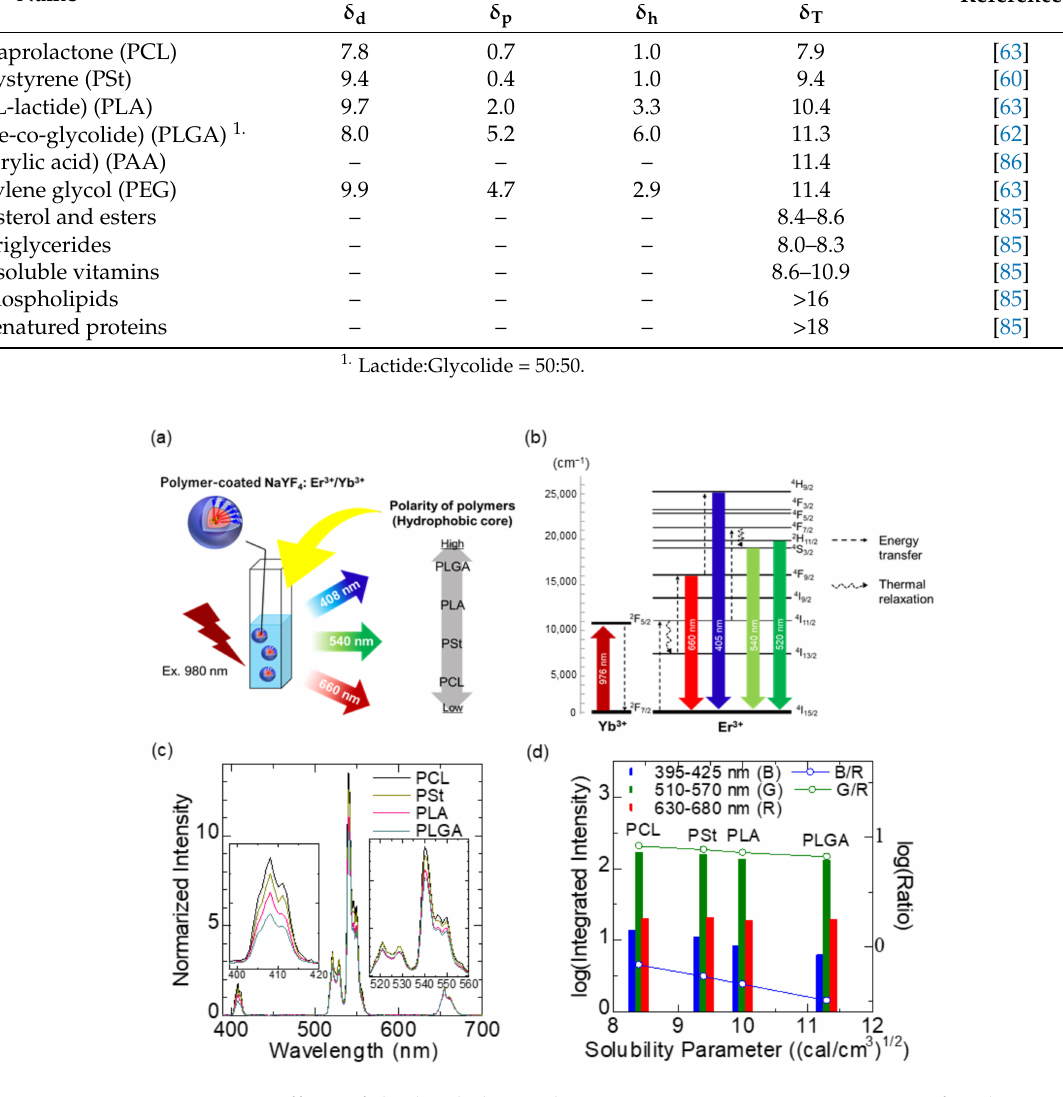
Figure 4. Effect of hydrophobic polymer on upconversion emission of polymer-coated NaYF 4 :Yb 3+ ,Er 3+ nanoparticles dispersed in water. ( a ) Illustration of the samples and the order of chemical polarities of the polymers. ( b ) Energy level diagram of NaYF 4 :Yb 3+ ,Er 3+ . ( c ) Upconver- sion spectra of polymer-coated NaYF 4 :Yb 3+ ,Er 3+ with different hydrophobic core polymers. Each spectrum shown is normalized with a peak height at 660 nm. ( d ) Integrated intensity of the up- conversion emission of each wavelength range and their ratio to the intensity of red (630–680 nm). The relationship between the emission intensities and the ratio with the solubility parameter of the hydrophobic core polymers is shown. Adapted from reference [83] with permission. Copyright 2021 Elsevier